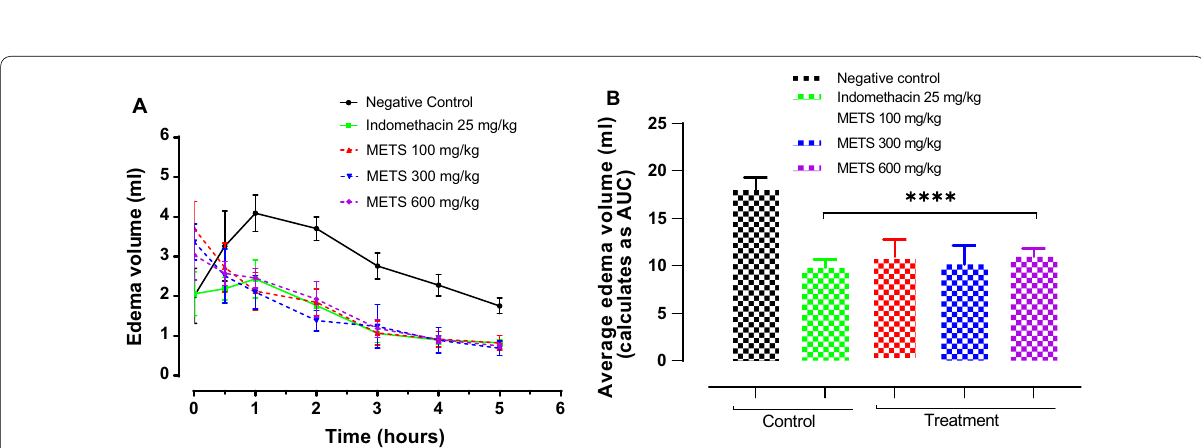
Fig. 2 Effect of METS treatment on edema volume (ml) ( a ) and total changes in edema volume measured as the area under concentration (AUC) in animals exposed to paw inflammation using CGN ( b